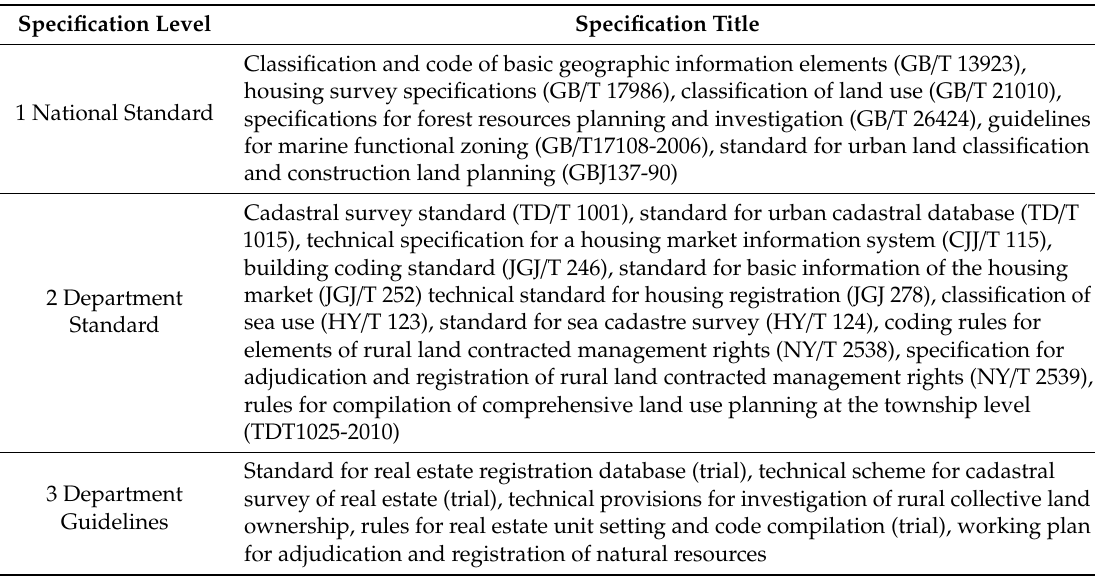
Table A2. Technical specifications for natural resource asset registration.